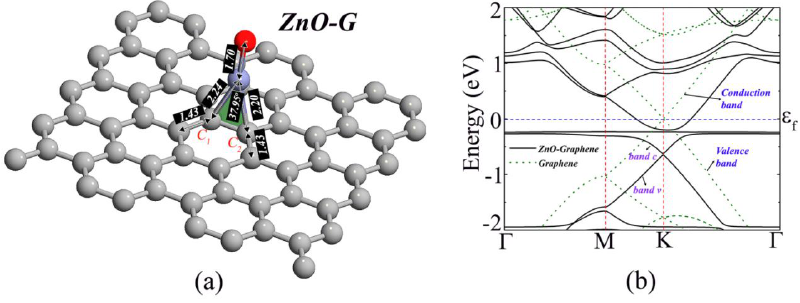
Figure 2. ( a ) Relaxed configuration of the ZnO adsorbed onto a graphene sheet. The gray, purple, and red balls signify C, Zn, and O atoms, respectively. The green area highlights the C 1 –Zn–C 2 angle. The bond lengths and the binding distances between the ZnO and the graphene sheet (in unit of Å ) are also given. ( b ) The band structures of pristine graphene (dashed green curves) and the ZnO–graphene hybrid (solid black curves).